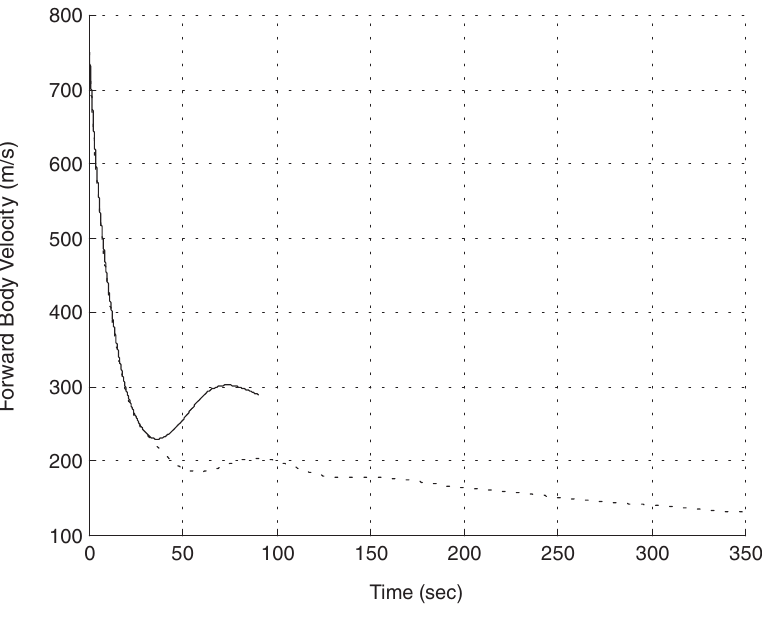
Fig. 9. Forward body velocity vs. time (Solid = Nominal, Dotted = Extended).